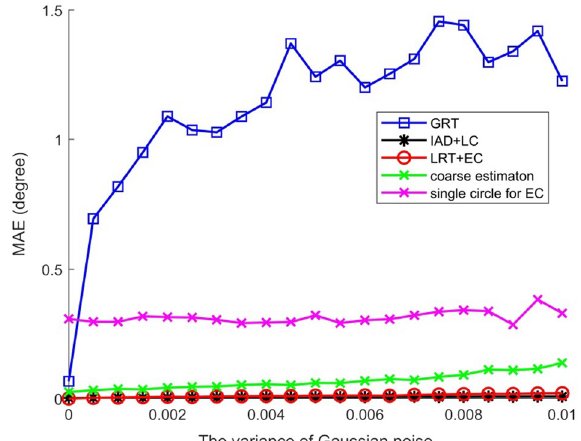
Fig. 7 Performance of algorithms with respect to